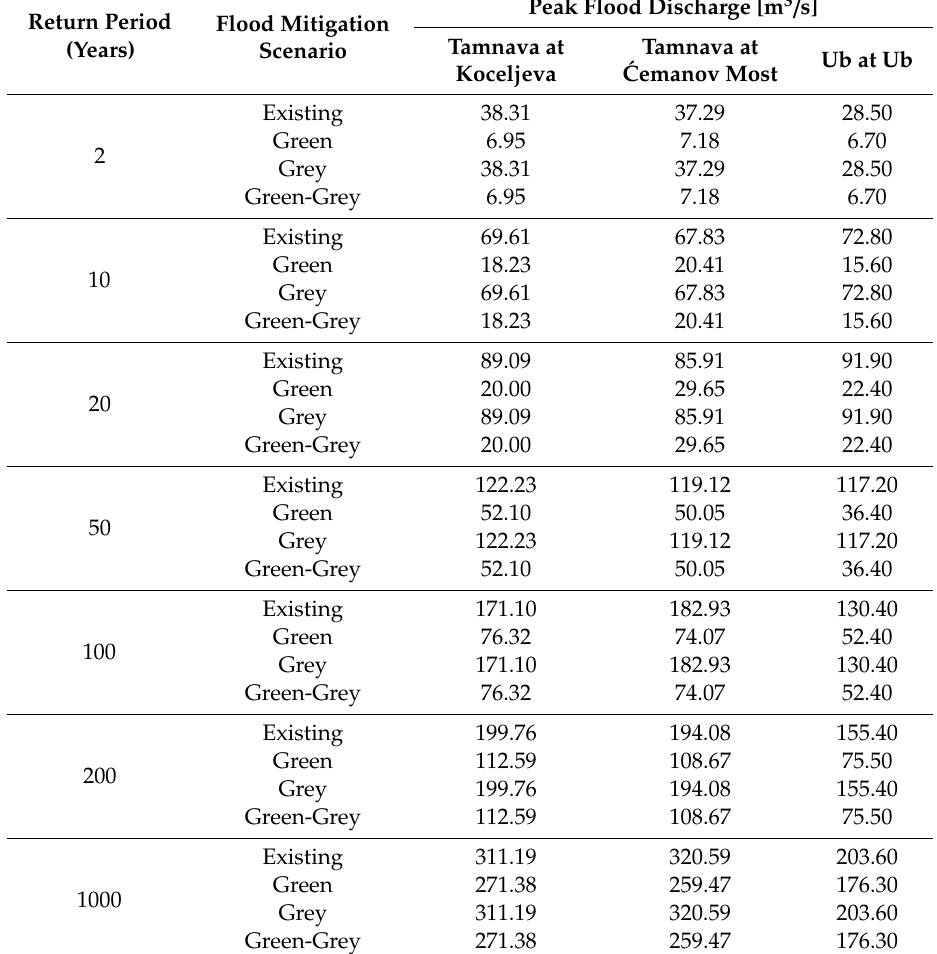
Table 5. Design flood flows at the Koceljeva, ´Cemanov Most, and Ub stream gauges under the four flood mitigations